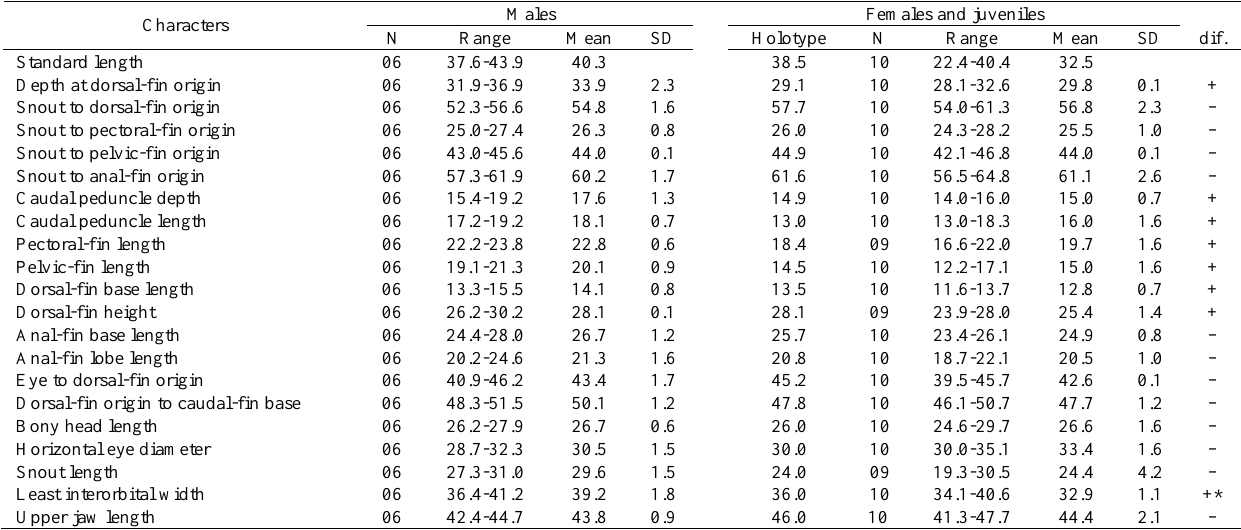
Table 4. Morphometrics of Glandulocauda caerulea . Standard length is expressed in mm; measurements through bony head length are percentages of standard length; the last four entries are percentages head length. A plus sign under the abbreviation dif. indicates there is a significant statistical difference between the males and females in the particular character indicated. Those receiving a plus sign and an asterisk are probably not significant. The type specimens, all from Serrinha Paraná, Brazil were described by Eigenmann as Glandulocauda melanopleura and include FMNH 54895 (holotype); FMNH 54896 (paratypes); USNM 177725 (paratype); CAS (IUM) 13273 (paratype). The following recently collected specimens are from near the type locality: MZUSP 53273 and USNM 326756. SD = Standard